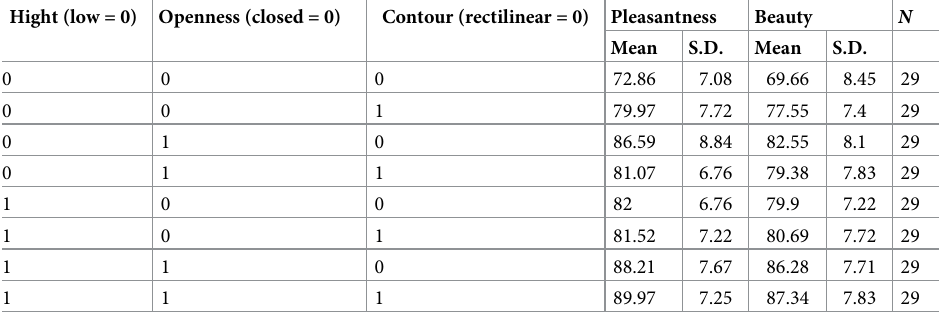
Table 3. Mean and SD of beauty and pleasantness